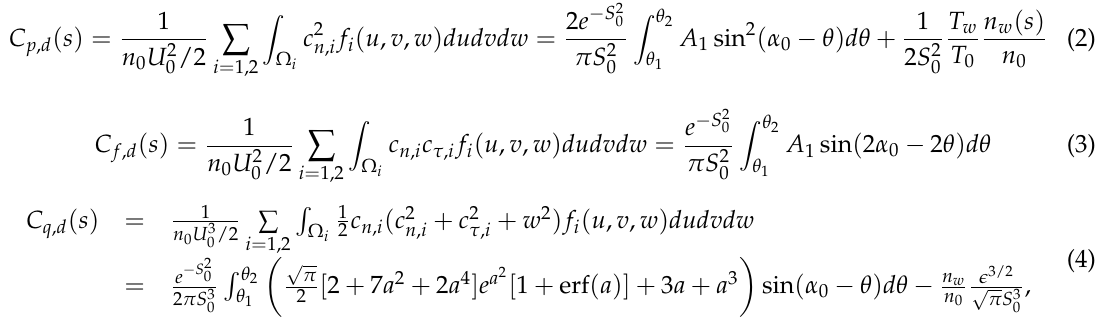
Figure 2. Velocity spaces for jet impinging on a planar, flat, diffuse reflective plate. Left : (cid:54) HFu = θ 1 , (cid:54) GFu = θ (cid:54) uoI = θ (cid:54) Jou = θ = α + β = α + π − β 2 ; Right : 3 0 2 , 0 4 1 . Integration and Ω 2 is for the reflected